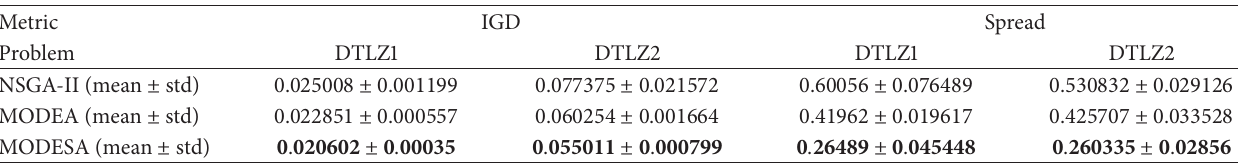
Table 5: The mean and standard deviation IGD-metric and Δ -metric values of nondominated solutions in 10 runs on DTLZ1 and DTLZ2 where 𝑁 = 100 and 𝑇 = 250 .